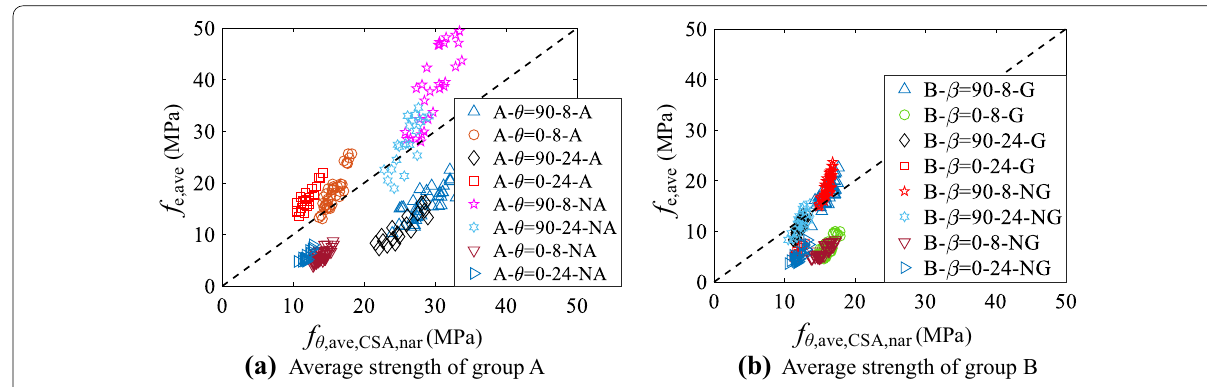
Fig. 18 Verification of the empirical Eq. (3)